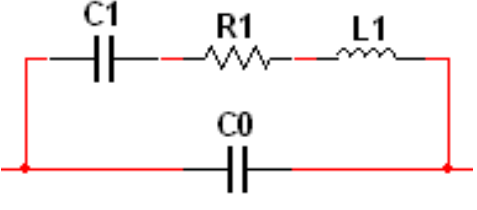
Figure 1. Electrical model of piezoelectric